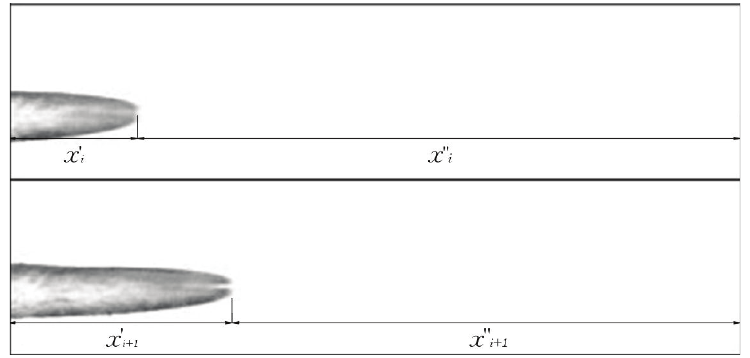
Figure 2. Measurement of cavitation profile.